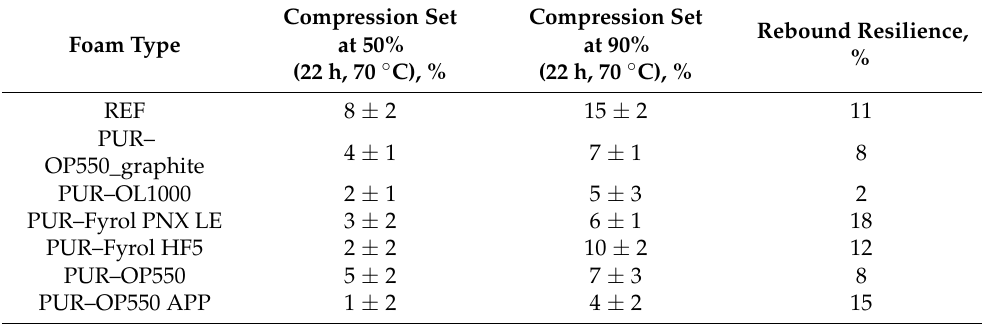
Table 8. Rebound resilience and compression set at 50% and 90%, depending on the flame retardant.